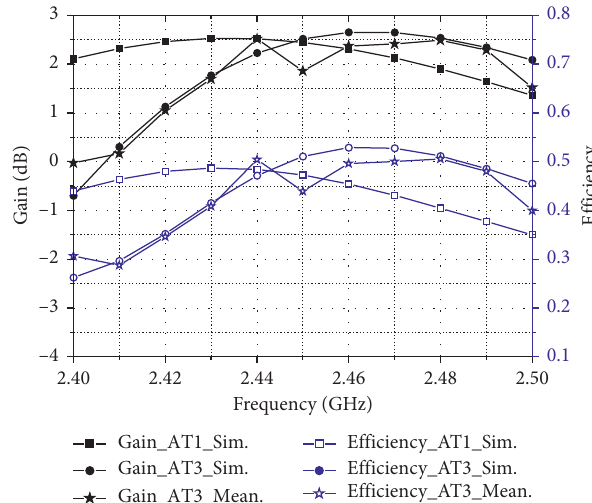
Figure 14: Gain and radiation efficiency of AT1 and